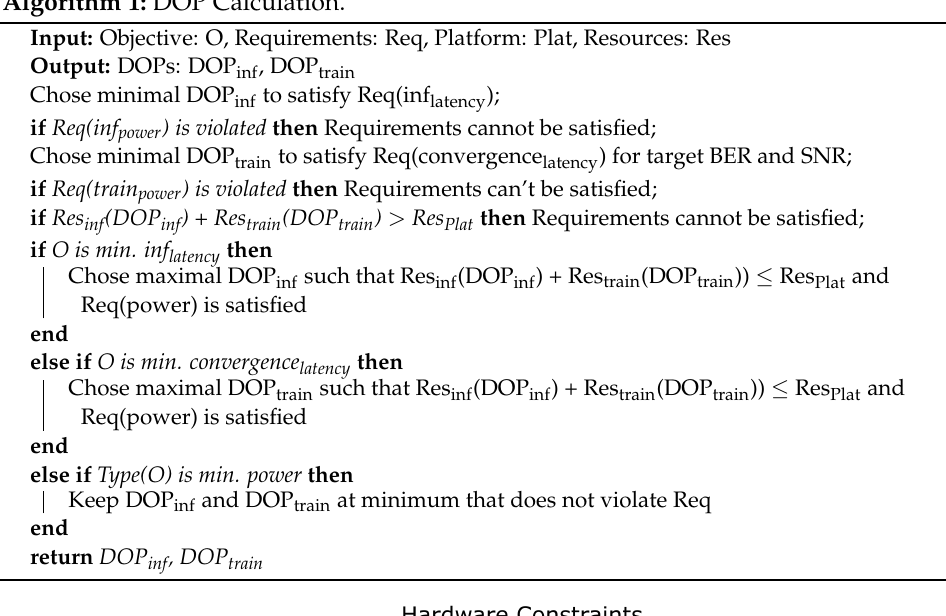
Algorithm 1: DOP Calculation.